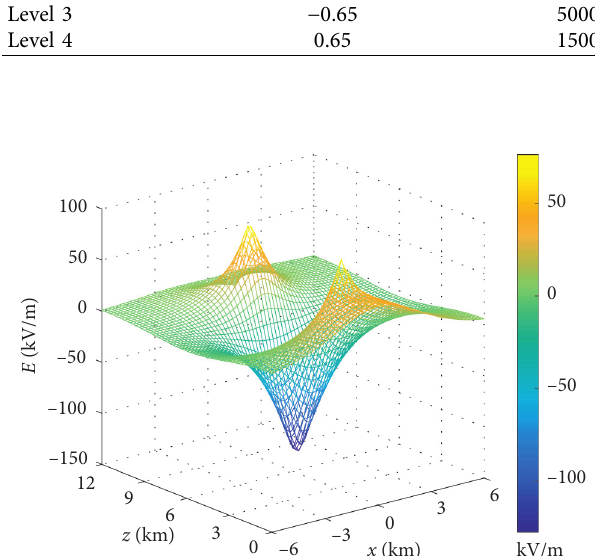
Figure 11: Electric field distribution on the longitudinal section while y � 4000m.